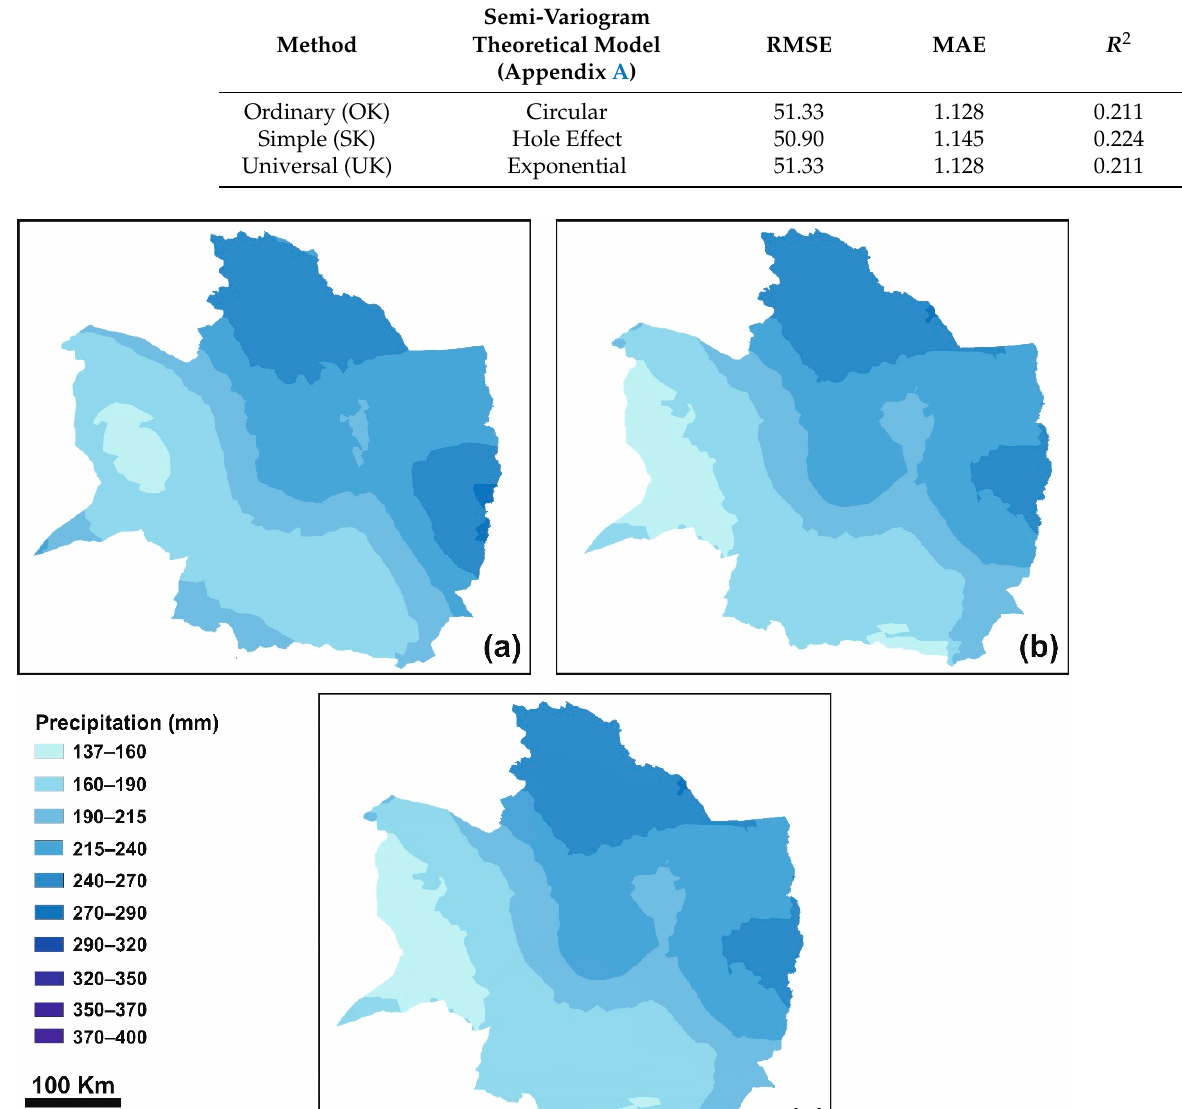
Table 4. Error values and R 2 for the three applied Kriging methods.